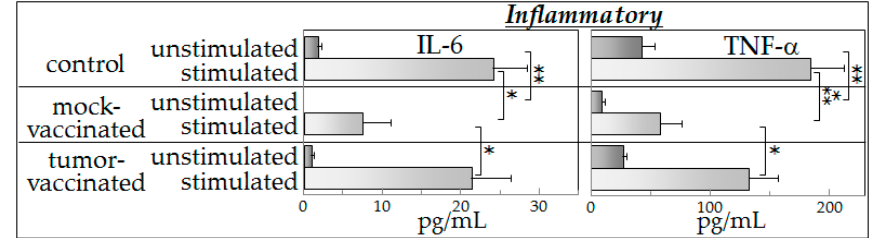
Figure 2. Mock-vaccinated glioma-bearing mice have a diminished capacity to produce inflammatory cytokines in response to the presence of tumor-derived products, but cytokine production is restored in vaccinated tumor-bearing mice. Spleen cells from control mice and from vaccinated or mock-vaccinated glioma-bearing mice were cultured either with control medium or with glioma-conditioned medium and their production of inflammatory cytokines IL-6 and TNF- α was measured. Data shown are means ± SEM, with spleen cell production of cytokines being measured in duplicate for each mouse individually. * p < 0.05, ** p < 0.01, *** p < 0.001.